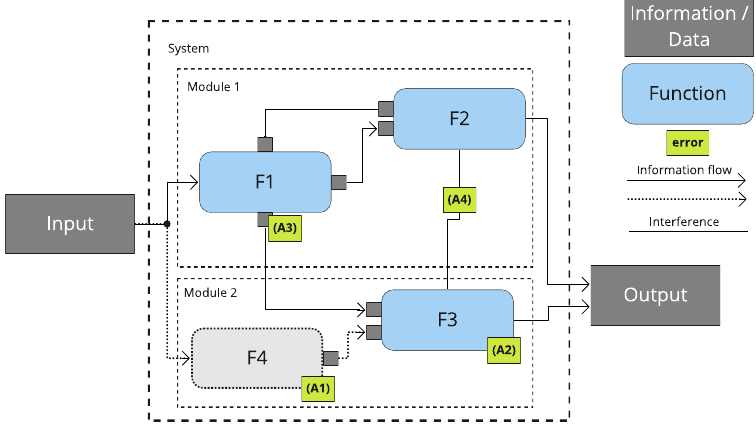
Figure 2. Exemplary abstracted functional architecture with functions F1–F4 including system and module boundaries visualized as UML activity diagram. Arrows are showing information flow, the line without arrows represents an interference. Dotted lines represent the added function F4 and its information flow after identification of error A1. Green boxes show the location of errors A1–A4 from the fault tree of error A.